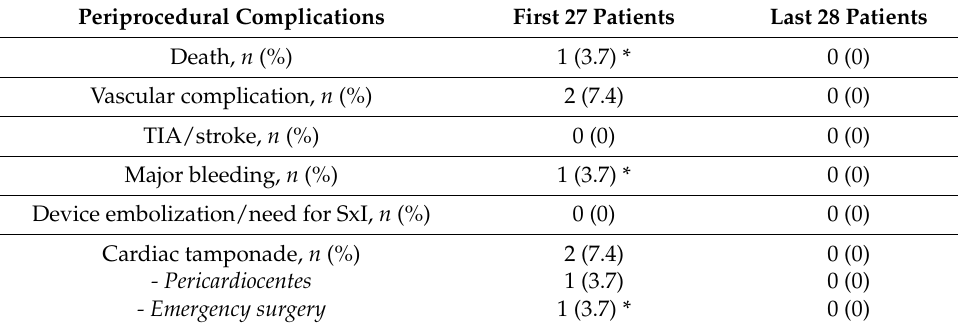
Table A1. Learning curve for LAAC with the LAmbre™ device ( n = 55).